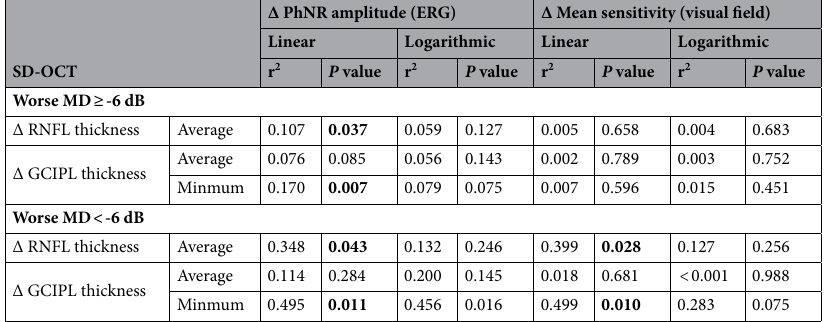
Table 7. The relationship between ΔRNFL or ΔGCIPL thickness and Δ photopic negative response (PhNR) or Δ mean sensitivity of standard automated perimetry between better and worse eyes according to glaucoma stage. ERG, electroretinogram; GCIPL, Ganglion cell-inner plexiform layer; MD, mean deviation; PhNR, photopic negative response; RNFL, retinal nerve fiber layer. Statistically significant values ( P < 0.05) are in bold.